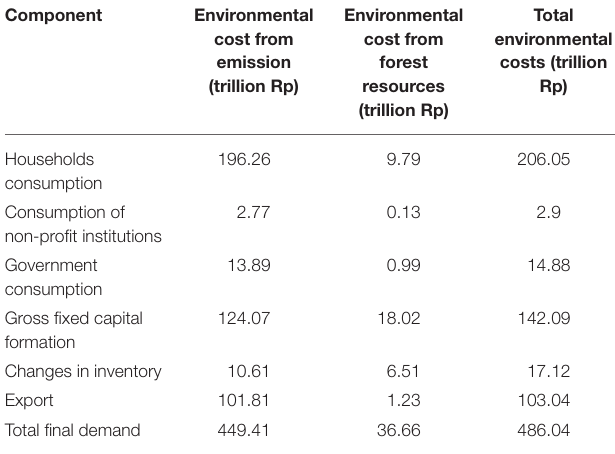
TABLE 5 | The environmental cost of timber resources due to final demand in Indonesia in 2010 (Trillion Rp). Components